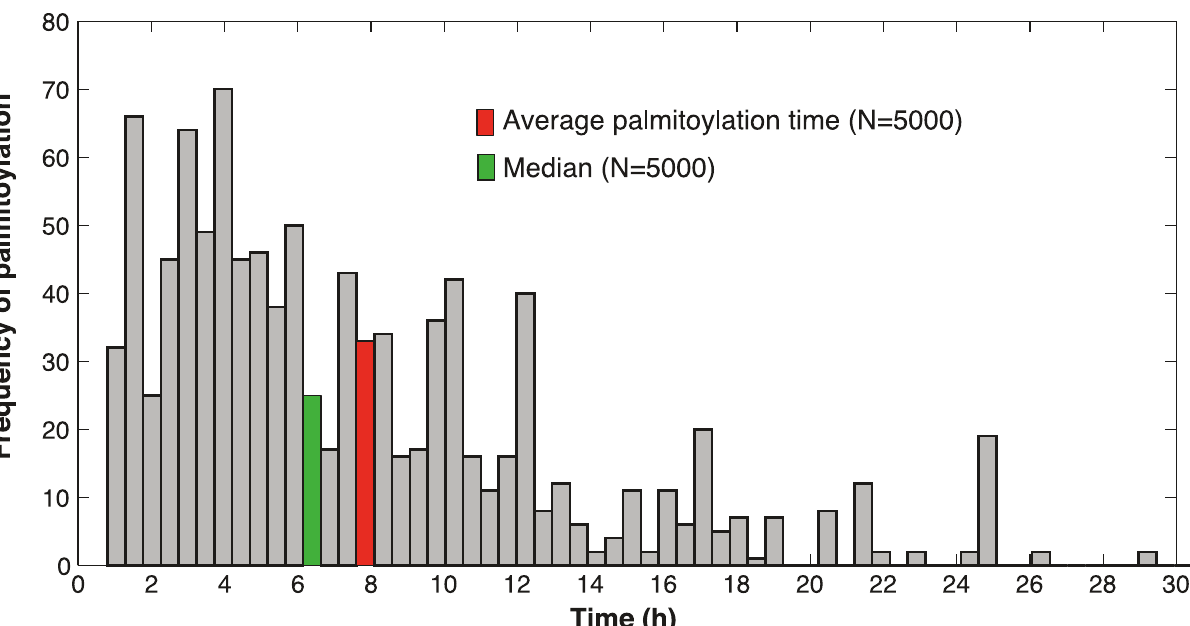
Fig 6. Stochastic simulations reveal the average palmitoylation time for calnexin. Single proteins were tracked in 5000 stochastic simulations of the labelling method described in Expanded View. From the simulations we estimated the average and median time requested for a single molecule of calnexin to undergo double